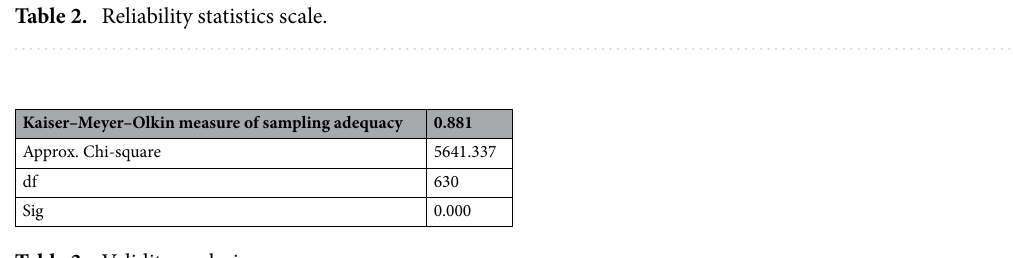
Table 3. Validity analysis.